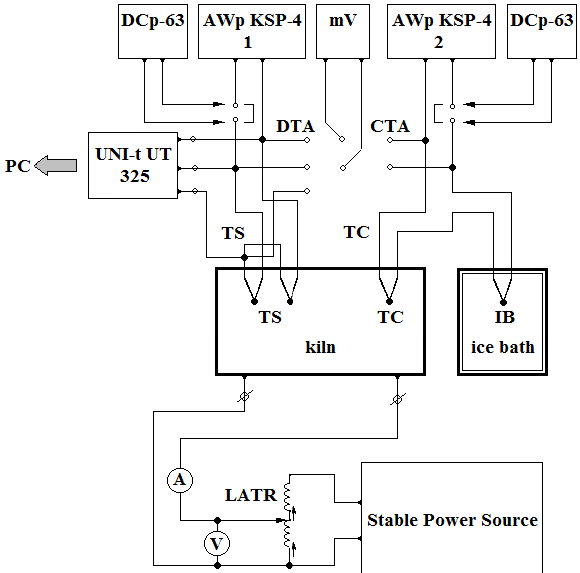
Figure 3. Scheme of settings for thermography of substances using CTA and DTA methods. DCp- 63—PP-63 DC potentiometer, KSP-4—auto-write potentiometers, LATR—laboratory autolab auto- transformer, TS—temperature sensor, IB—temperature isothermal block, DTA—differential thermal analysis, CTA—cyclic thermal analysis.